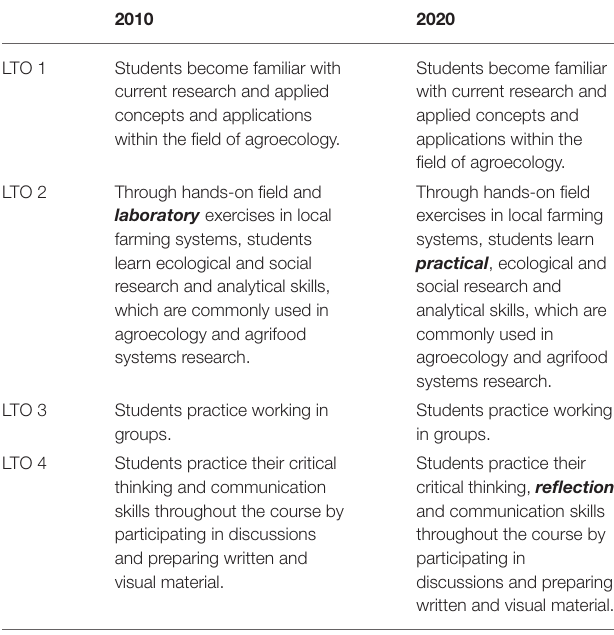
TABLE 1 | Learning and teaching outcomes (LTOs) as listed in course